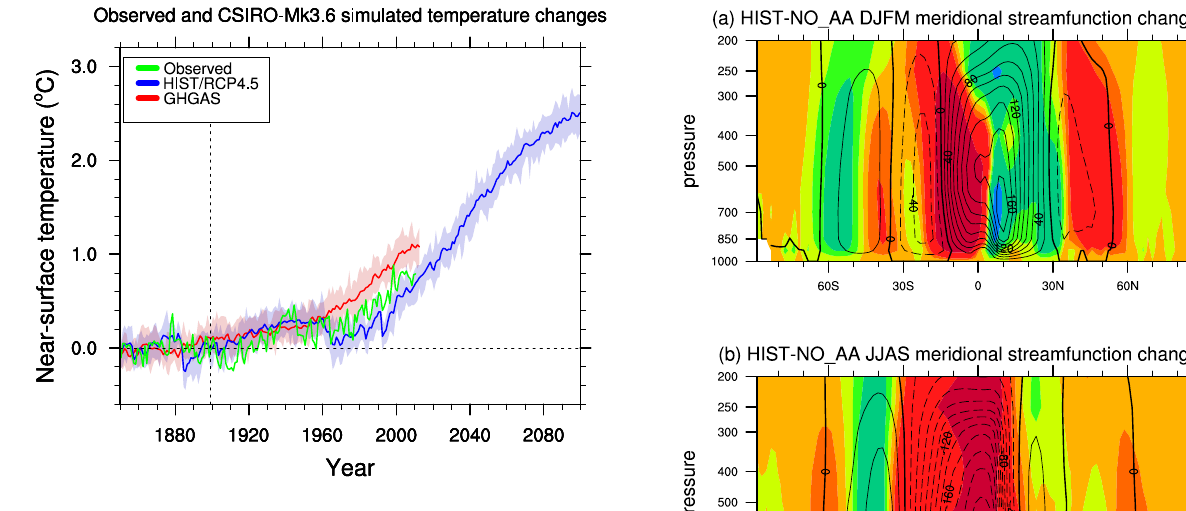
Fig. 3. Anomalies of annual, global-mean near-surface temperature from observations and the model (comprising SST over oceans, and near-surface air temperature over land). Solid lines show the ensemble mean, and shading shows the range of individual runs within each ensemble. Observations and the model both use their own 1850–1899 mean in the calculation of anomalies.